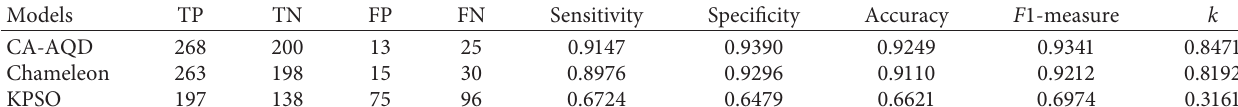
Table 4: The accuracy and Cohen kappa index among CA-AQD, Chameleon, and KPSO. Models